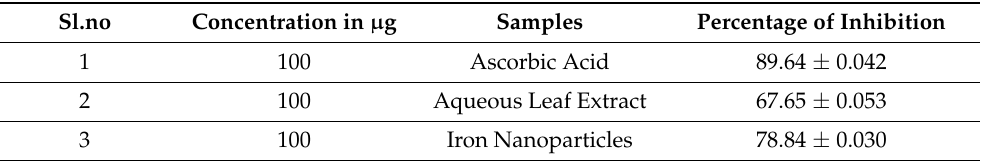
Table 6. In vitro anti-inflammatory effect of aqueous leaf extract of V. leucoxylon and its synthesized iron